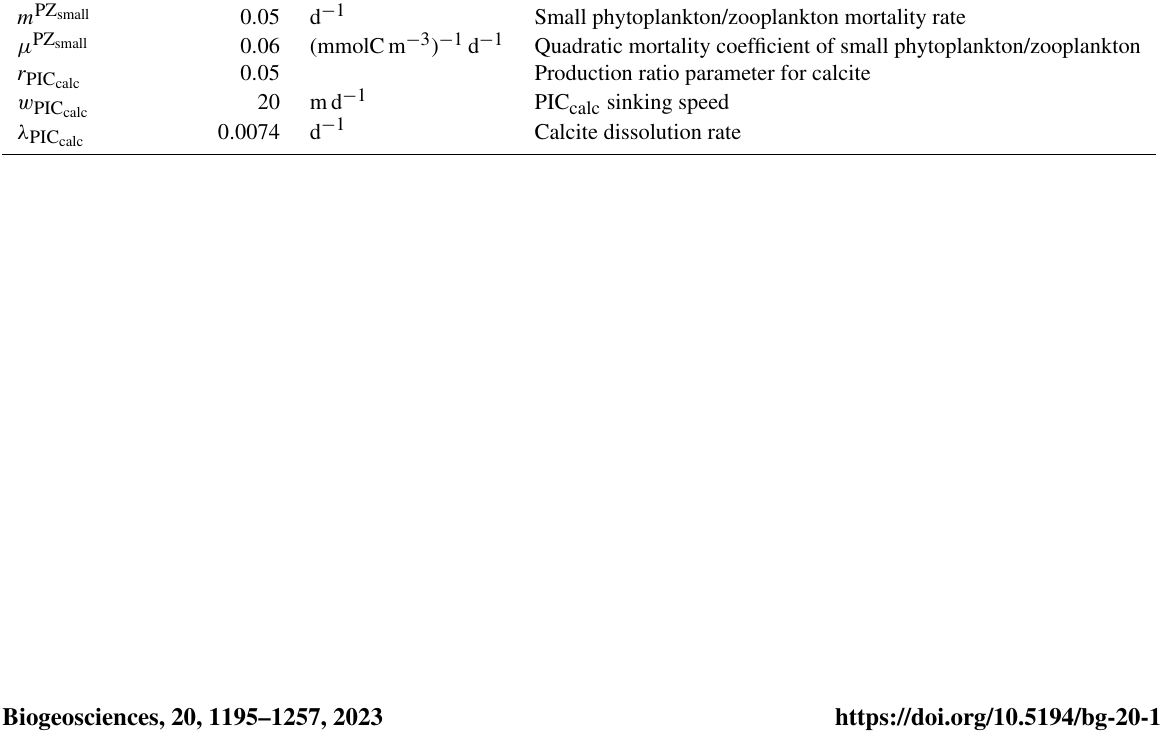
Table C3. CanOE parameters. Variable/parameter Value